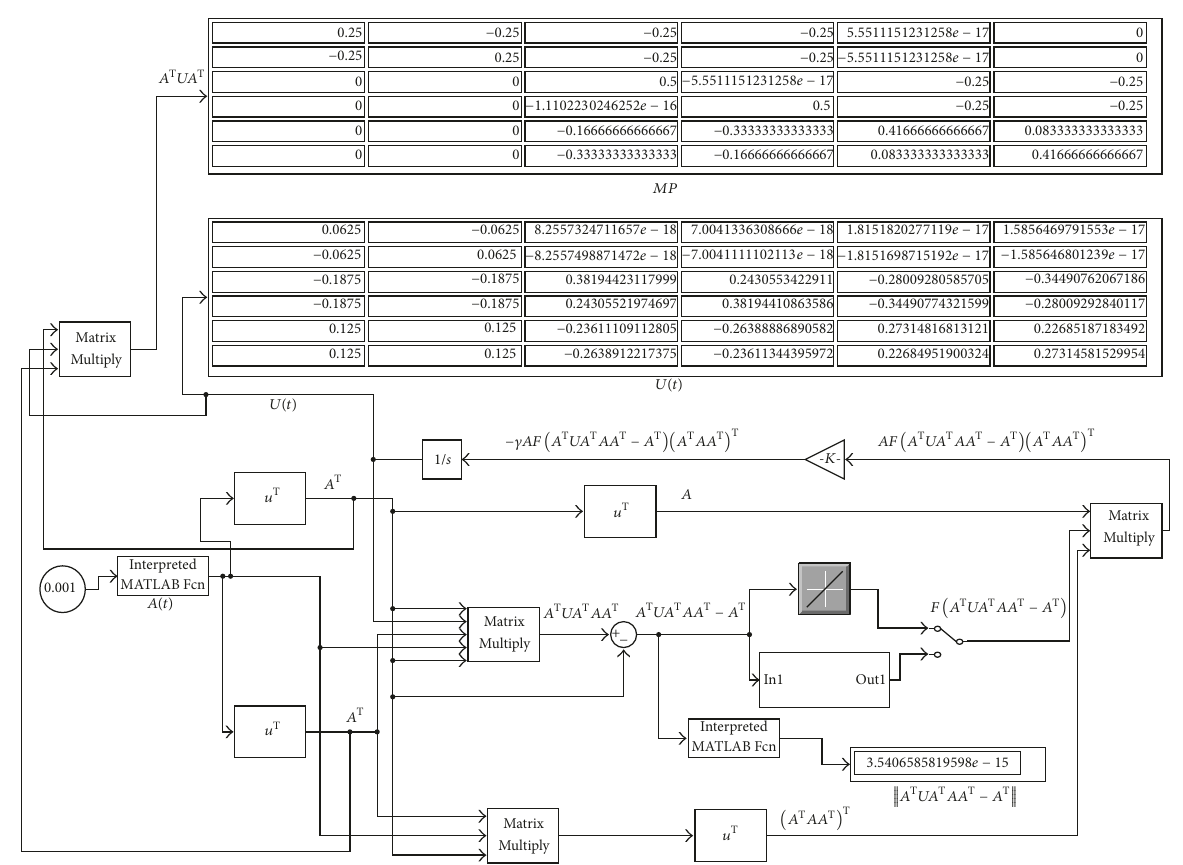
Figure 7: Simulink implementation of the GNN model for computing 𝐴 † using Algorithm